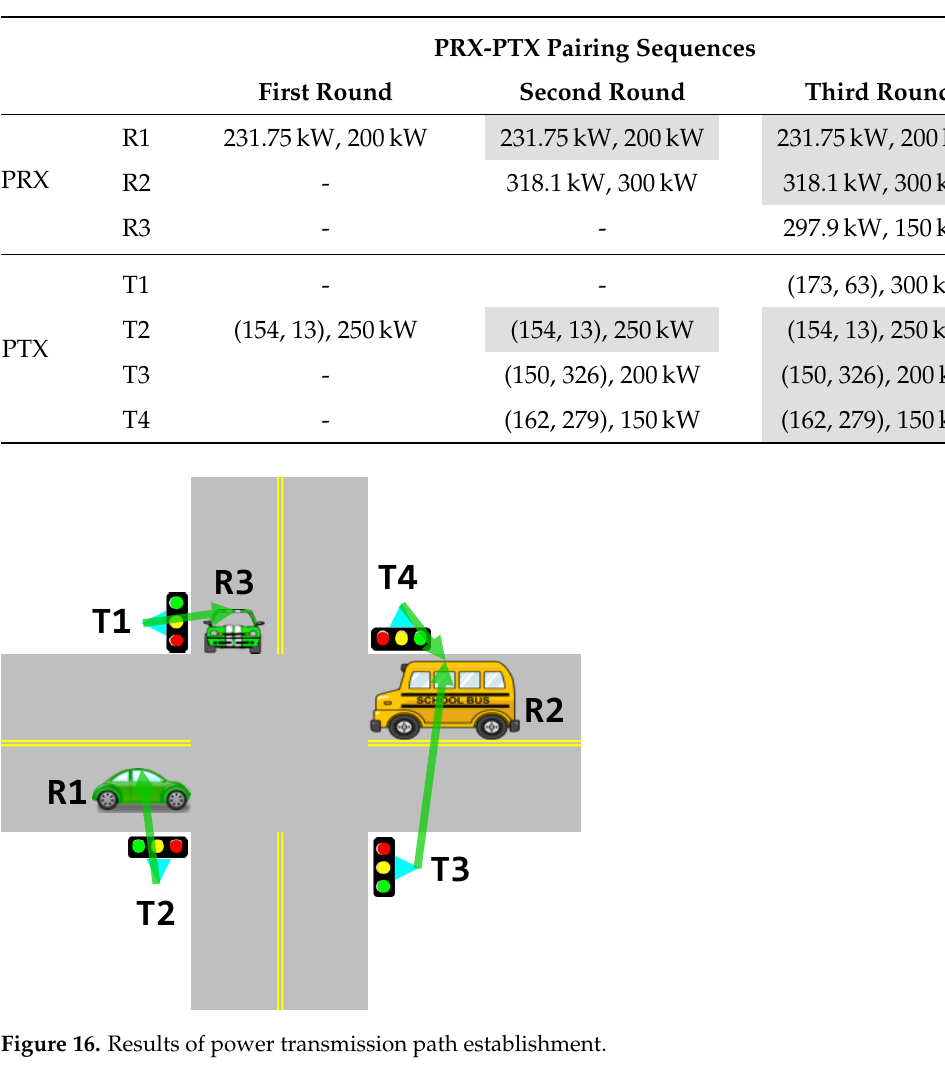
Table 9. Results of WPC using the best PTE-based PTX selection algorithm.